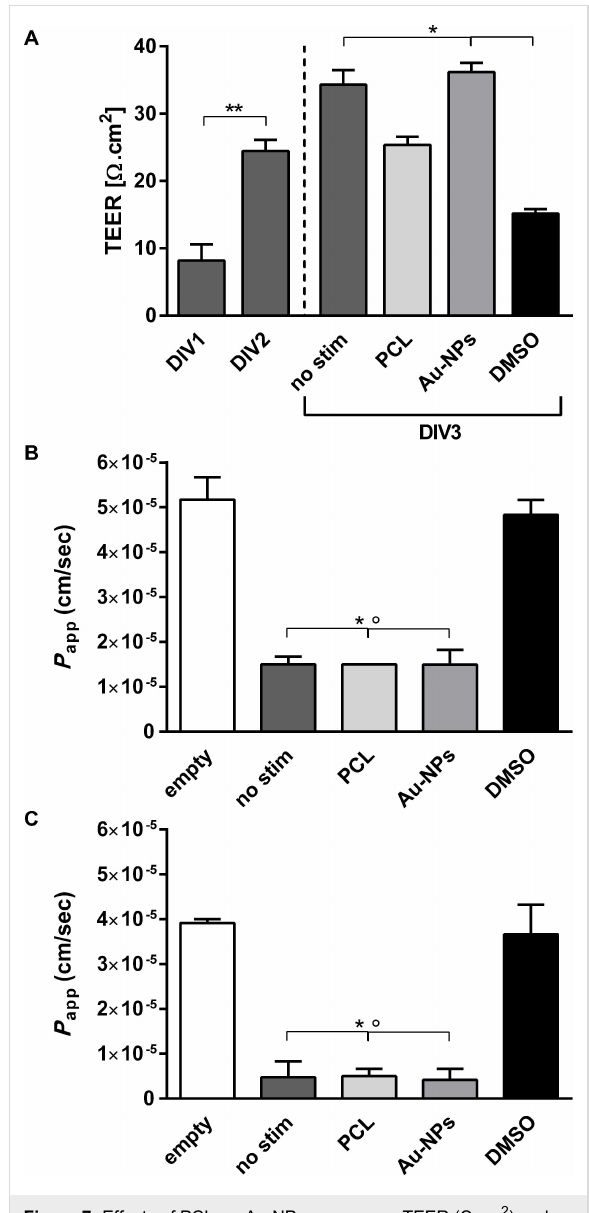
Figure 7: Effects of PCL- or Au-NP exposure on TEER ( Ω ·cm 2 ) and permeability of an rBCEC4 monolayer. Permeability is indicated by P app (cm/s). An increase in TEER was observed over the 3 days in cul- ture (DIV: days in vitro). DMSO resulted in a significant decrease of TEER whereas NP exposure did not. The dashed line signifies the start of NP exposure and DMSO stimulation (A). None of the NPs ex- amined led to a change in permeability, regardless of the tracer used – 4.4 kDa TRITC dextran (B) or 70 kDa FITC dextran (C). Concentra- tions were [24.9 µg/mL] for PCL-NPs, [160.3 µg/mL] for Au-NPs and 10% DMSO. Error bars represent SEM. Significant differences to empty filters and DMSO are labeled with asterisks (*) or circles (°), re- spectively (B, C). (°/* = p ≤ 0.01; ** = p ≤ 0.0001).